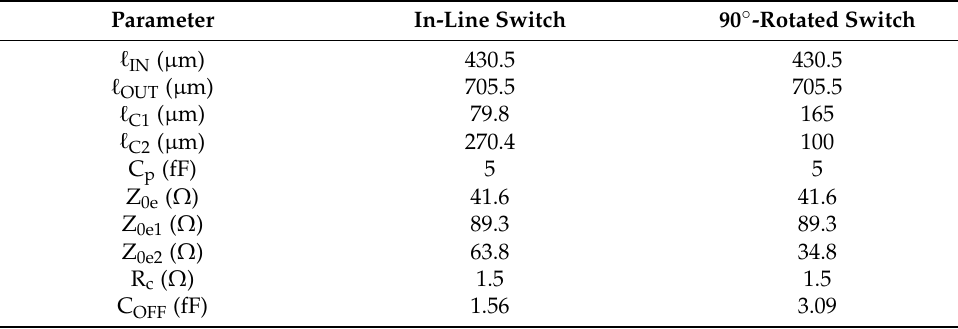
Table 3. Equivalent circuit elements (Figure 8) and layout dimensions (Figure 6). Parameter In-Line Switch 90 ◦ -Rotated Switch Figure 6. Layout of an RF-MEMS switch embedded in a planar rectangular cavity at a size of 430 μ m × 360 μ m defined on a CPW structure, showing the main dimensions (see Table 3 for ℓ IN , ℓ OUT , ℓ C1 and ℓ C2 ). P1 and P2 are the 50- Ω CPW even-mode input/output RF ports. A DDG-W in-line and a DDG-NW 90°-rotated (inset) configurations are shown as examples. The different layers are la- beled according to Figure 4.